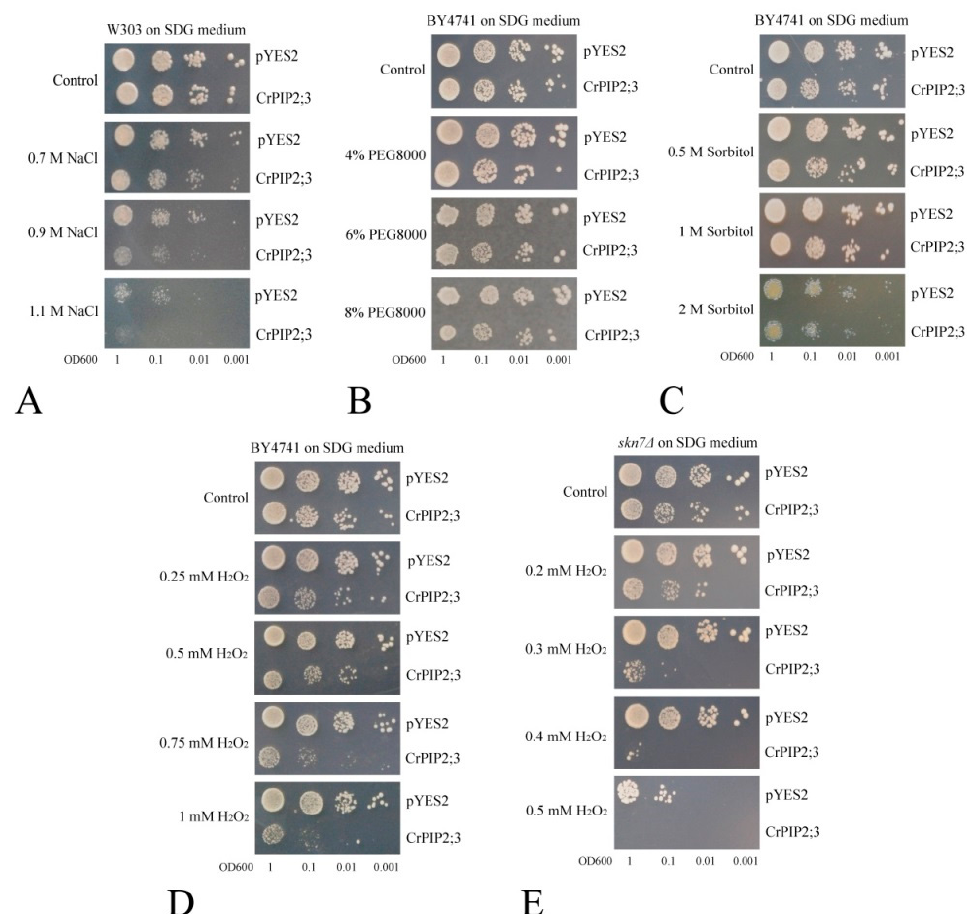
Figure 4. Spot assay for salt, osmotic stress, and H 2 O 2 tolerance in yeast. Dot-spot assays for ( A ) salt-tolerance (different concentrations of NaCl) in the yeast wild-type (W303) expressing CrPIP2;3 (carrying CrPIP2;3 -pYES DEST52) or control (carrying pYES2); ( B ) high osmotic stress tolerance (different concentrations of PEG8000) in the yeast wild-type (BY4741); ( C ) high osmotic stress tolerance (different concentrations of sorbitol) in the yeast wild-type (BY4741); ( D ) oxidative stress tolerance (different concentrations of H 2 O 2 ) in the yeast wild-type (BY4741), and ( E ) oxidative stress tolerance (different concentrations of H 2 O 2 ) in the H 2 O 2 -sensitive yeast mutant strain skn7 ∆